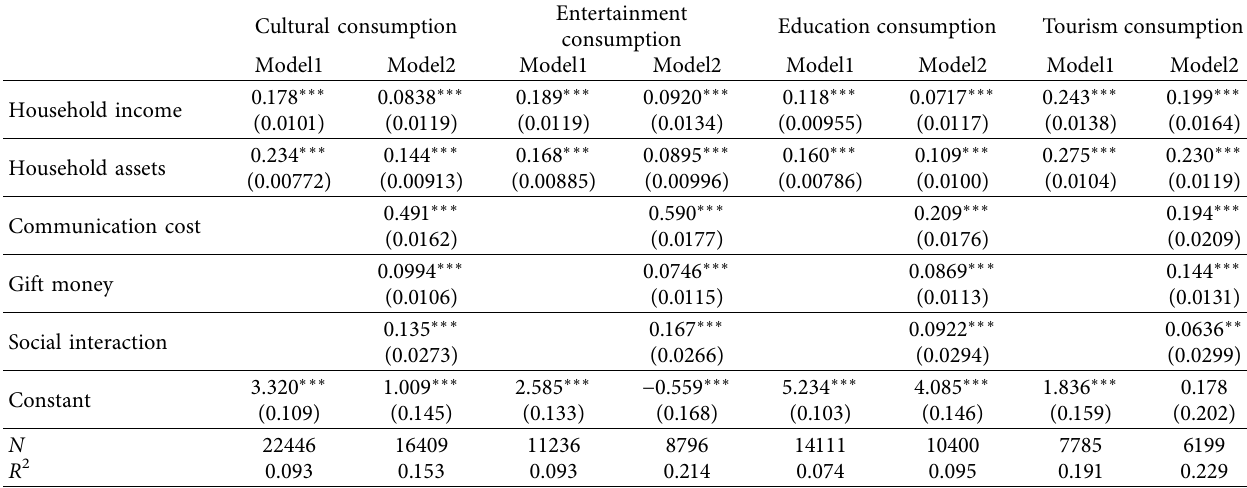
Table 2: Impact of social networks on cultural consumption